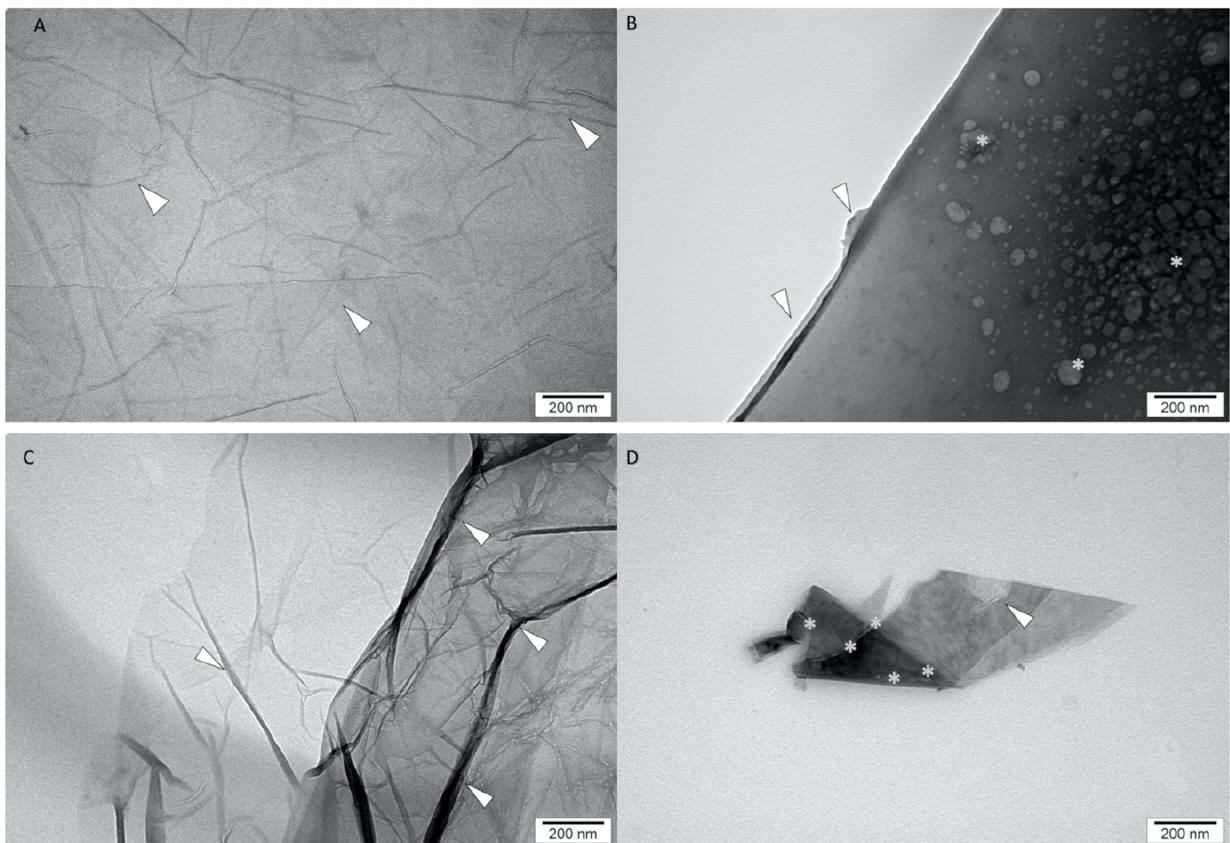
Figure 2. Transmission electron microscopy images of graphene oxide ( A ), reduced graphene oxide ( C ), graphene oxide functionalised with miRNA ( B ) and reduced graphene oxide functionalised with miRNA ( D ). Arrows: GO, rGO fakes corrugation, * miRNA, Scale bars: 200 nm.